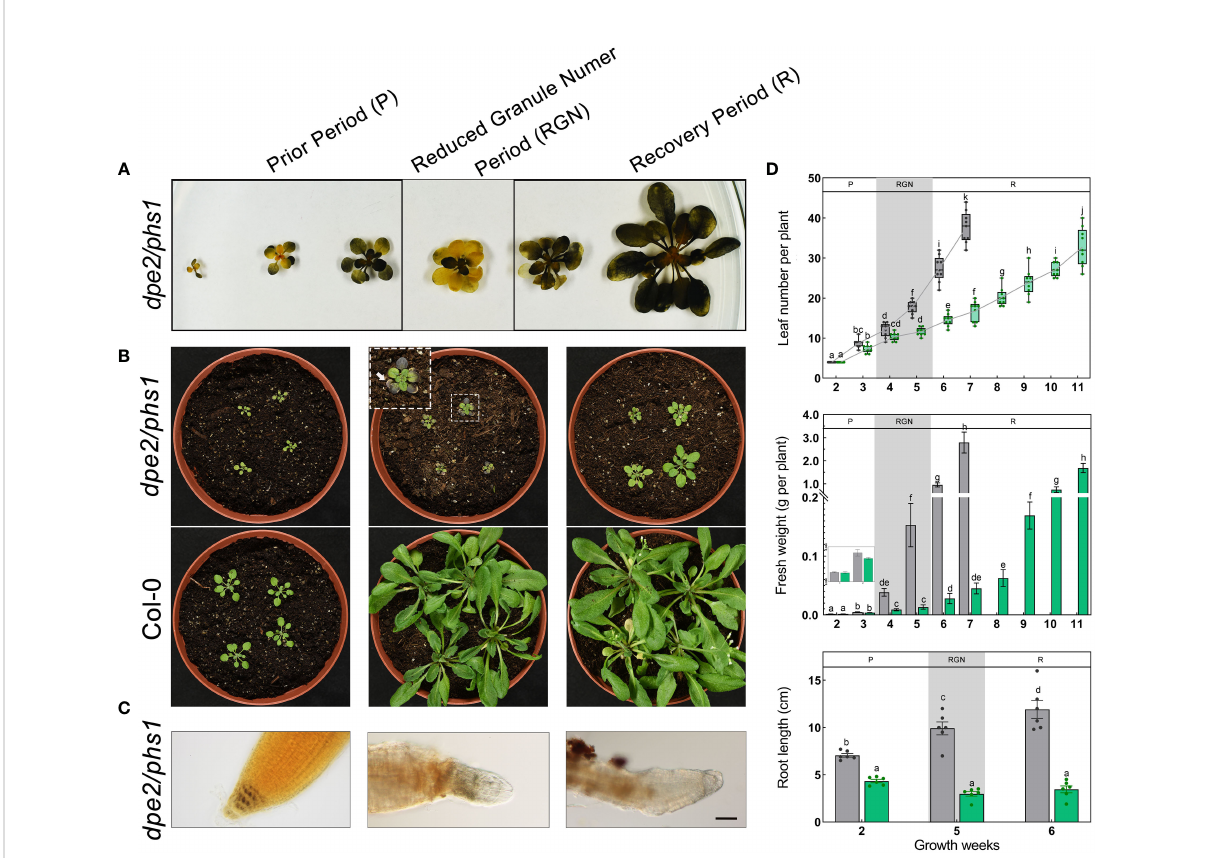
FIGURE 2 dpe2/phs1 showed three distinguishable periods when grown under light/dark regime: (A) Semi-quantitative starch determination. Shoots harvested at the EOD from two to seven weeks, decolorized shoots were stained with iodine solution; (B) Growth phenotype of dpe2/phs1 from the three periods. Shoots were harvested at three, fi ve, and six weeks, respectively; (C) Starch in root caps. The starch in the root caps was stained with I 2 solution. Bars = 50 m m; (D) Growth parameters of dpe2/phs1 . Plants were analyzed from two weeks until fl owering. Grey and green colors indicate Col-0 and dpe2/phs1 , respectively. Letters indicate statistically signi fi cant differences (p ≤ 0.05) among the double mutant and Col-0, according to the one-way ANOVA with Duncan ’ s post-hoc test. More than nine plants were analyzed for determination of leaf number and fresh weight per week. Roots of plants at two, fi ve, and six weeks were used, and six plants each were analyzed. P-Prior Period; RGN-Reduced Granule Number Period; R-Recovery